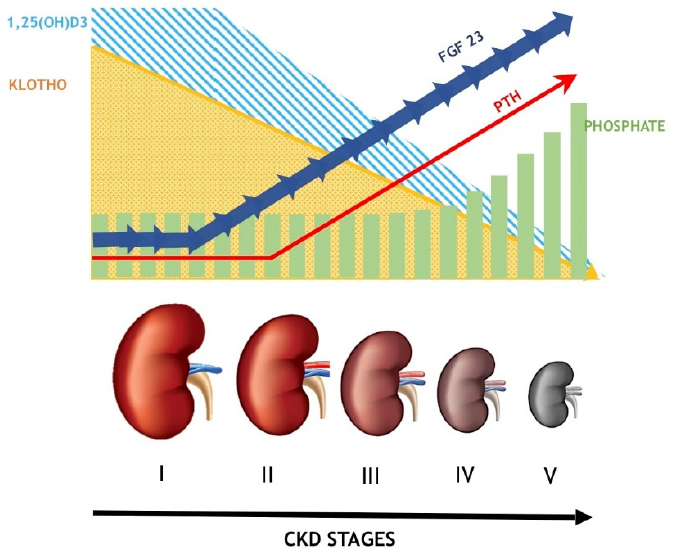
Figure 2. Correlations between serum levels of Klotho, FGF-23, vitamin D, phosphate, and PTH during CKD progression.